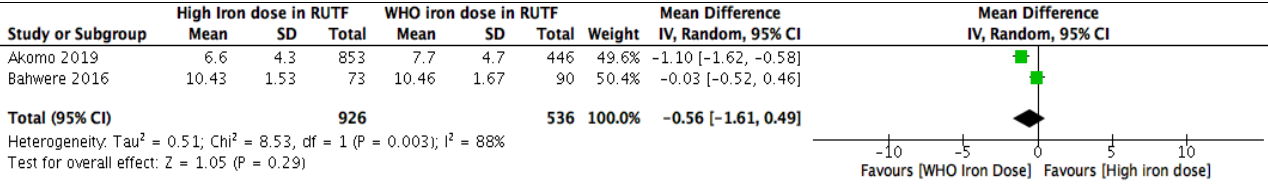
Figure 9. Effect of SMS-based RUTF with high iron content compared to that of peanut-based RUTF with WHO standard iron content on weight gain. The forest plot shows pooled data from two of the included studies. Raw values were used, and an intention-to-treat analysis was preferred, where available. The pooled results show a potential decrease in weight gain with RUTF with high iron content compared to RUTF with WHO standard iron content. Akomo 2019 [4]. has two study